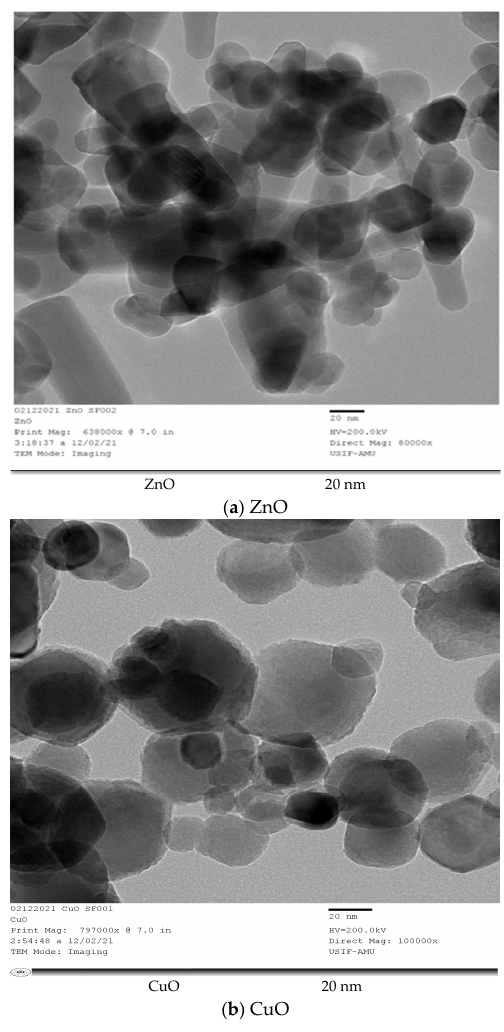
Figure 2. TEM images of ( a ) ZnO and ( b ) CuO nanoparticles.